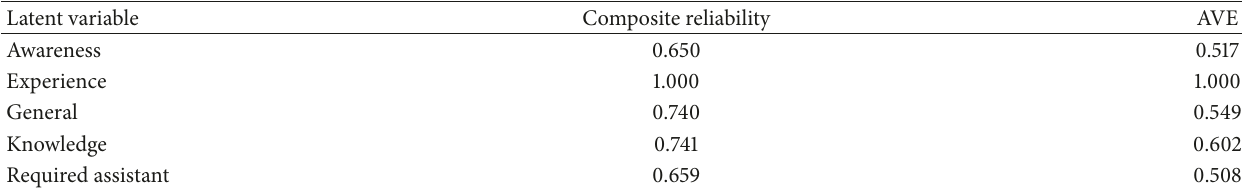
Table 7: Reliability and validity for